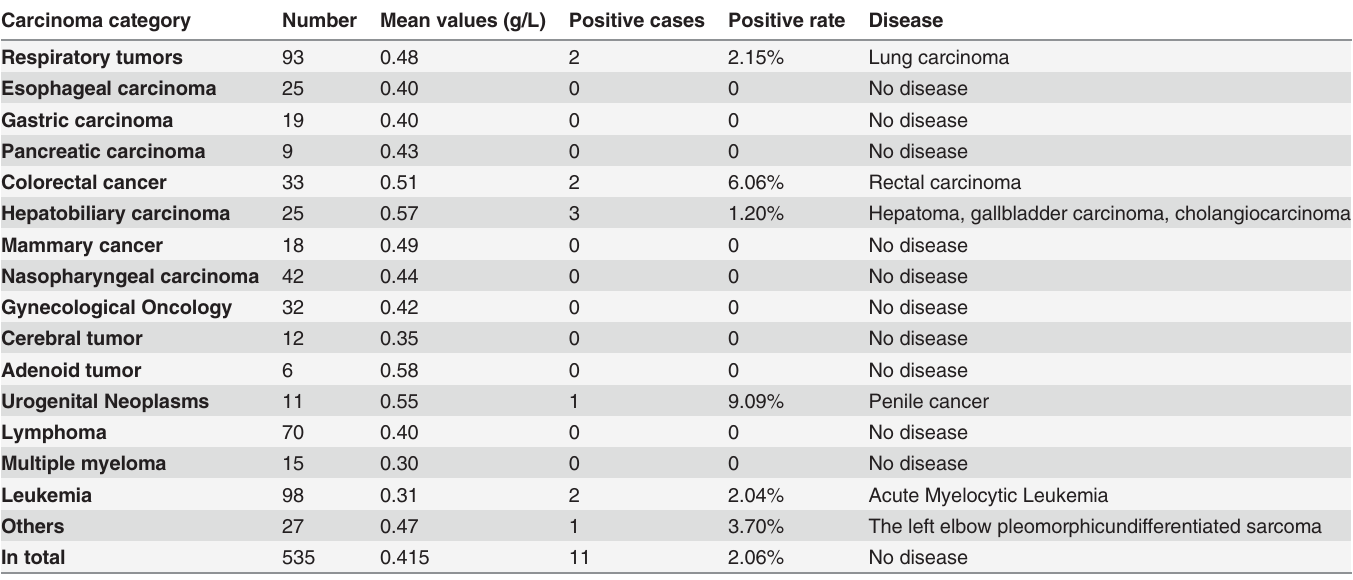
Table 2. Elevated levels of serum IgG4 in carcinoma diseases. Carcinoma